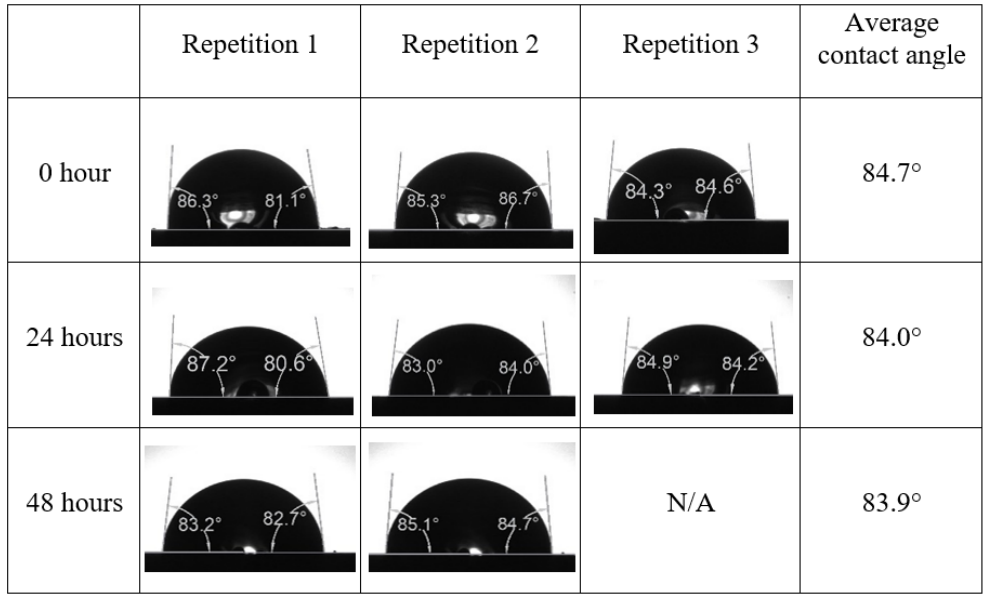
Figure A24. Dynamic Contact Angle Measurement Results for 50% Na 2 SO 4 + 50% NaCl (3500 ppm).